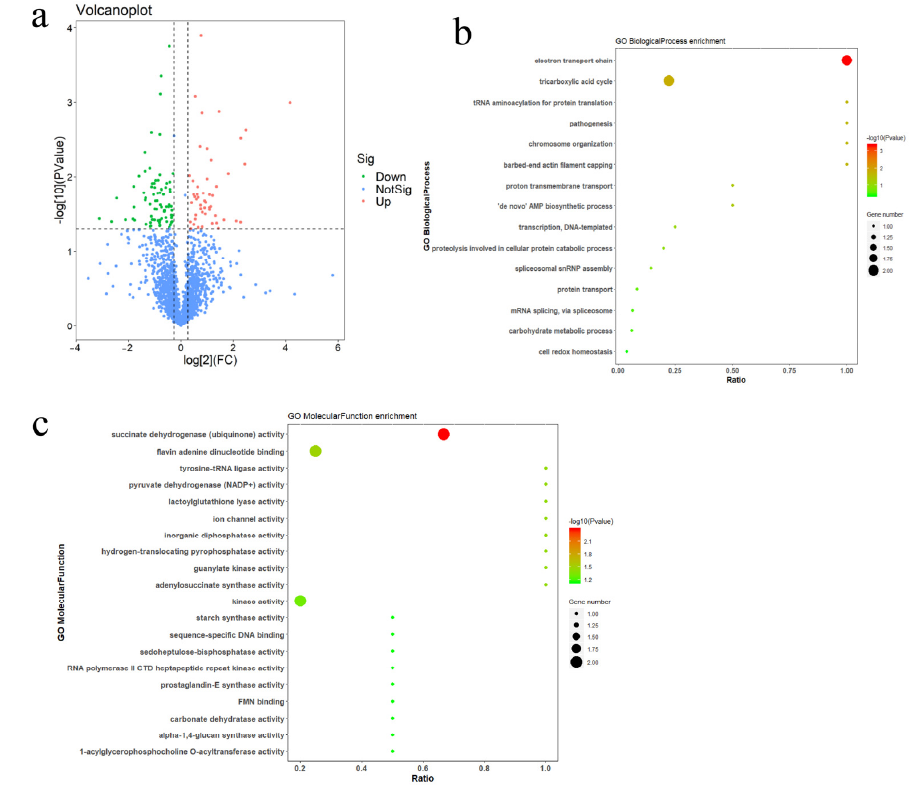
Figure 8. The comparative proteome of Δ grx S14 Δ grx C5 and Nc1. ( a ) Volcano plots showing log 2 protein ratios vs. − log 2 p values of the global proteome in Δ grx S14 Δ grx C5 compared to Nc1 para- sites. ( b ) Gene Ontology (GO) analysis of proteins with downregulated expressions in Δ grx S14 Δ grx C5 compared to Nc1 parasites based on biological process and ( c ) molecular function (see Supple- mentary Dataset S1).